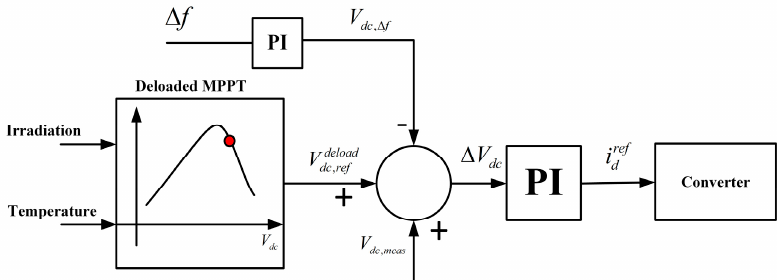
Figure 17. De-loaded operation control for solar photovoltaic (PV).